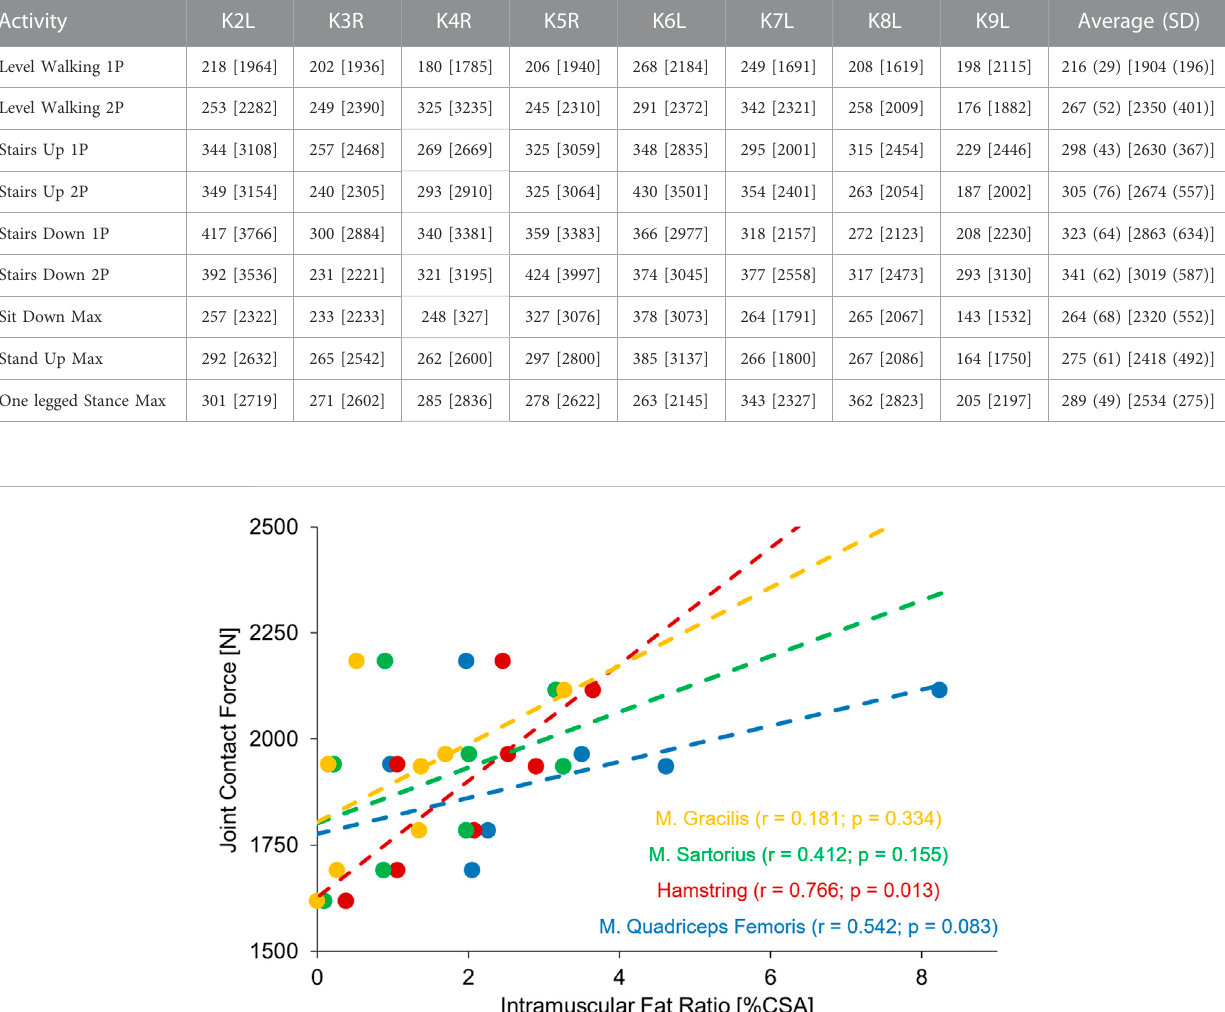
FIGURE 3 Correlation betwéen the intramusular fat ratio and the in vivo knee joint loading during typical activities of daily